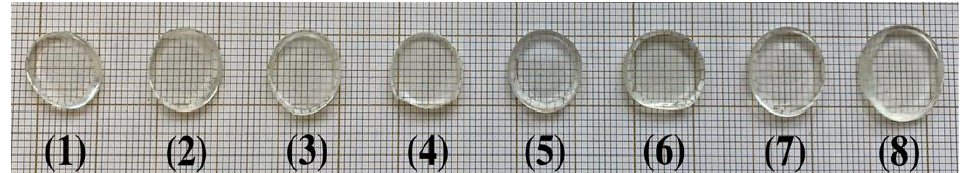
Figure 1. Photographs of the Dy 3+ doped glass samples: GeO 2 -BaO-Ga 2 O 3 (1), GeO 2 :B 2 O 3 = 11:1 (2), GeO 2 :B 2 O 3 = 5:1 (3), GeO 2 :B 2 O 3 = 2:1 (4), GeO 2 :B 2 O 3 = 1:1 (5), GeO 2 :B 2 O 3 = 1:2 (6), GeO 2 :B 2 O 3 = 1:5 (7) and B 2 O 3 -BaO-Ga 2 O 3 (8).